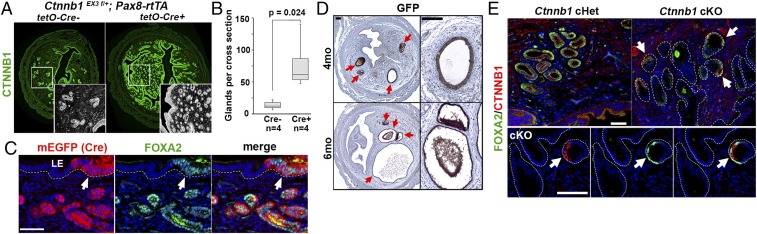
CTNNB1 exon 3 deletion promotes neoadenogenesis in the mature uterine epithelium. (A) The number of uterine glands per uterine cross-section was compared between CTNNB1 GOF mutant (Cre+) and control (Cre−) at PD60. (B) Boxplot presentation of uterine gland density in Ctnnb1 exon 3 deletion mutant and control uteri. UtE-specific expression of mutant CTNNB1 in PD21 mice significantly increases the number of uterine glands at PD60 (P = 0.024). (C) Deletion of Ctnnb1 exon 3 by Cre (detected by mEGFP reporter expression) induced FOXA2 expression (arrow) in the luminal epithelium (LE). Epithelial basement membrane is highlighted by a dotted line. (D) Sustained CTNNB1 activity in UtE resulted in nonproliferative cysts (red arrows). (E) FOXA2 and CTNNB1 expression in the luminal and glandular epithelium of Ctnnb1 conditional heterozygous (cHet) and knockout (cKO) mice. In cKO mice, FOXA2 expression was detected only in glandular cells retaining CTNNB1 (arrows). (Scale bars: C and D, 50 μm; E, 100 μm.)